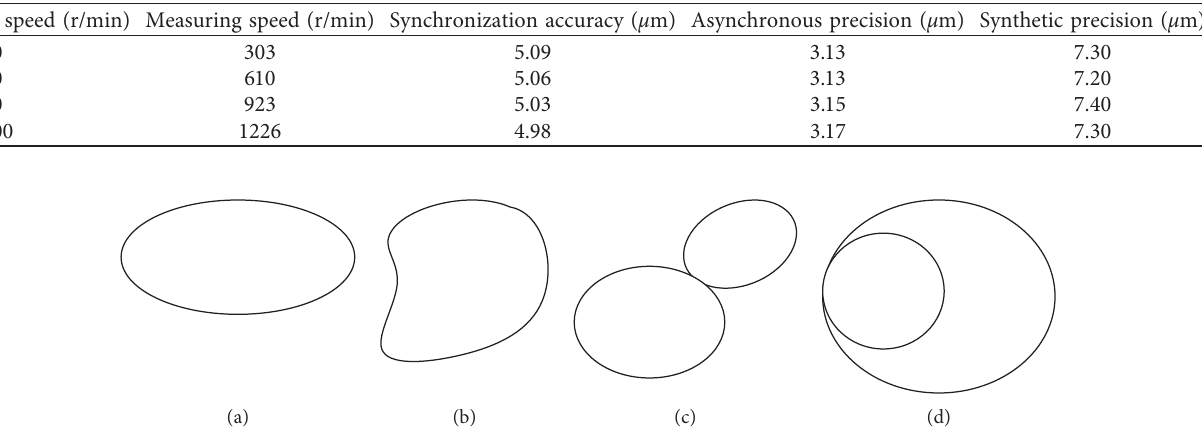
Figure 21: The diagram of common rotor axis trace. (a) Ellipse. (b) Banana leaf shape. (c) Eight-character shape. (d) Inner double-ring shape.